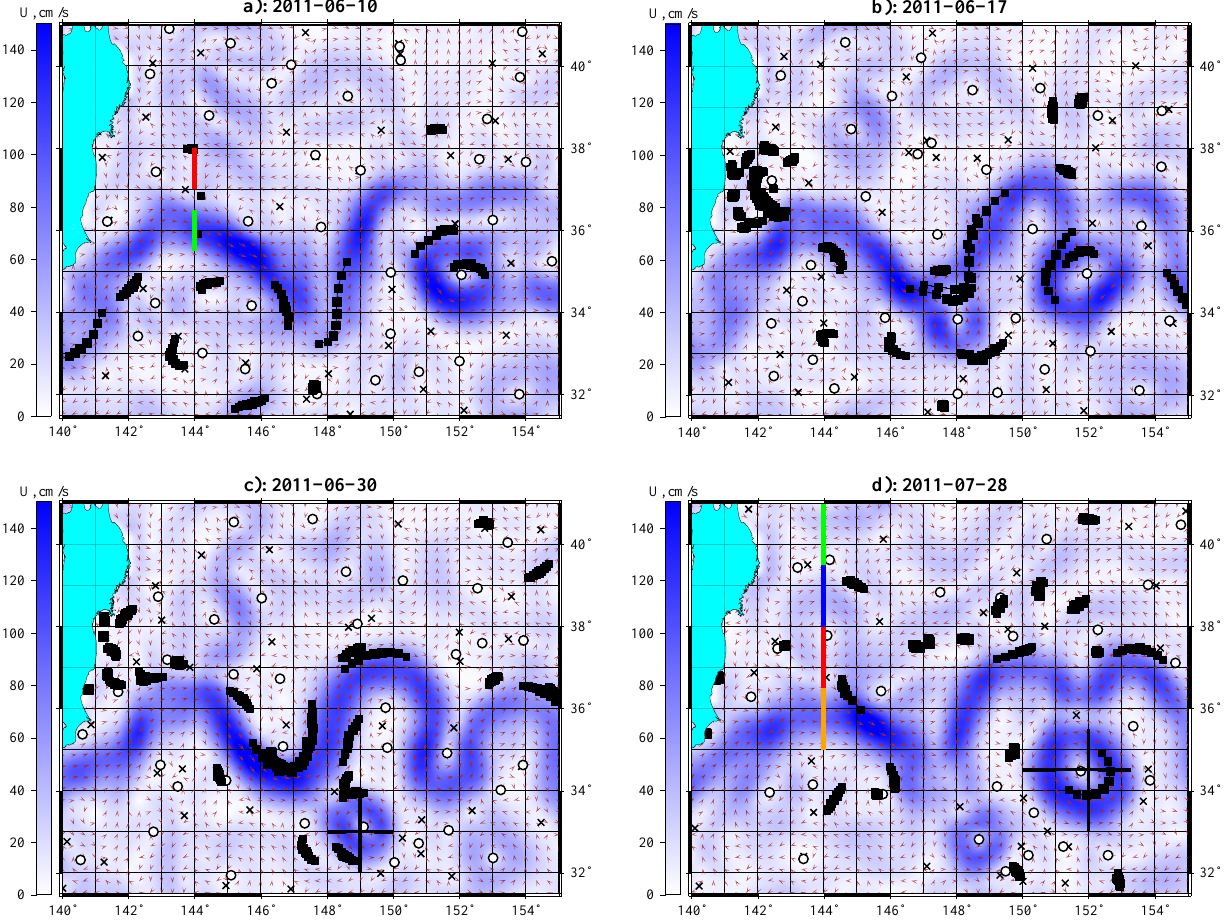
Fig. 2. (a) – (c) Metamorphoses of the velocity field in the process of formation of the CR1 on 10 June, 17 June and 30 June 2011, respectively, with tracks of drifters imposed. (d) Velocity field on 28 July 2011 with the CR2 separated from the jet. Nuances of blue color measure the modulus of the linear velocity U in cms − 1 . Crosses and open circles mark “instantaneous” hyperbolic and elliptic stagnation points, respec- tively. The straights are material lines that have been evolved backward in time to trace origin of the corresponding markers. Perpendicular black lines cross the CR1 and CR2. Colored lines in (a) and (d) are placed along the transects where seawater samples have been collected on 10 and 11 June 2011 during the R/V Ka’imikai-O-Kanaloa cruise (Buesseler et al., 2012) and on 26–29 July 2011 during the R/V Kaiun maru cruise (Kaeriyama et al., 2013),